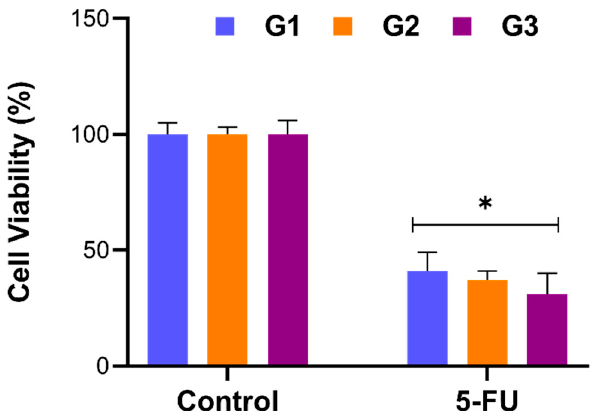
Figure 5. Evaluation of the cytotoxic activity of 5FU-loaded PAMAM-conjugated di-n-dodecylamine micelles (DL-G1, DL-G2, DL-G3). AGS cells were exposed to 15 µ M 5FU-loaded 25 µ M DL-G1, DL-G2, and DL-G3 micelles for 24 h, and cell viability was assessed by WST-1 assay. Data were presented as the percentage of cell viability relative to the control group of each generation. Error bars represent the standard deviation of the mean (* p < 0.05).